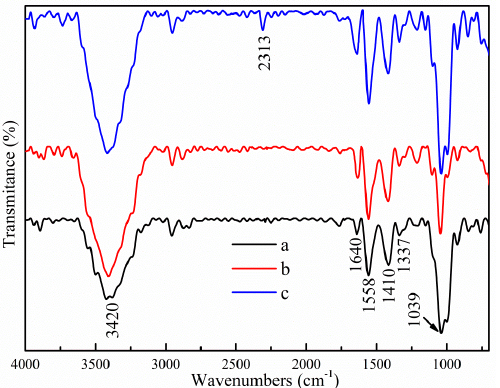
Figure 1. FTIR spectra of different samples. ( a ) Control; ( b ) 3% TiO 2 -N; and ( c ) 9% CO-3% TiO 2 -N.